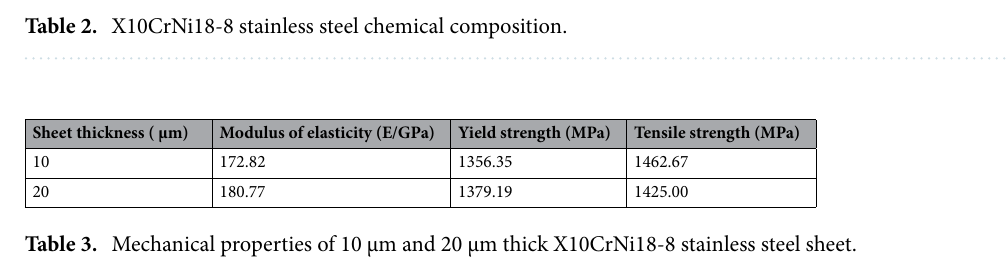
Table 3. Mechanical properties of 10 μm and 20 μm thick X10CrNi18-8 stainless steel sheet.